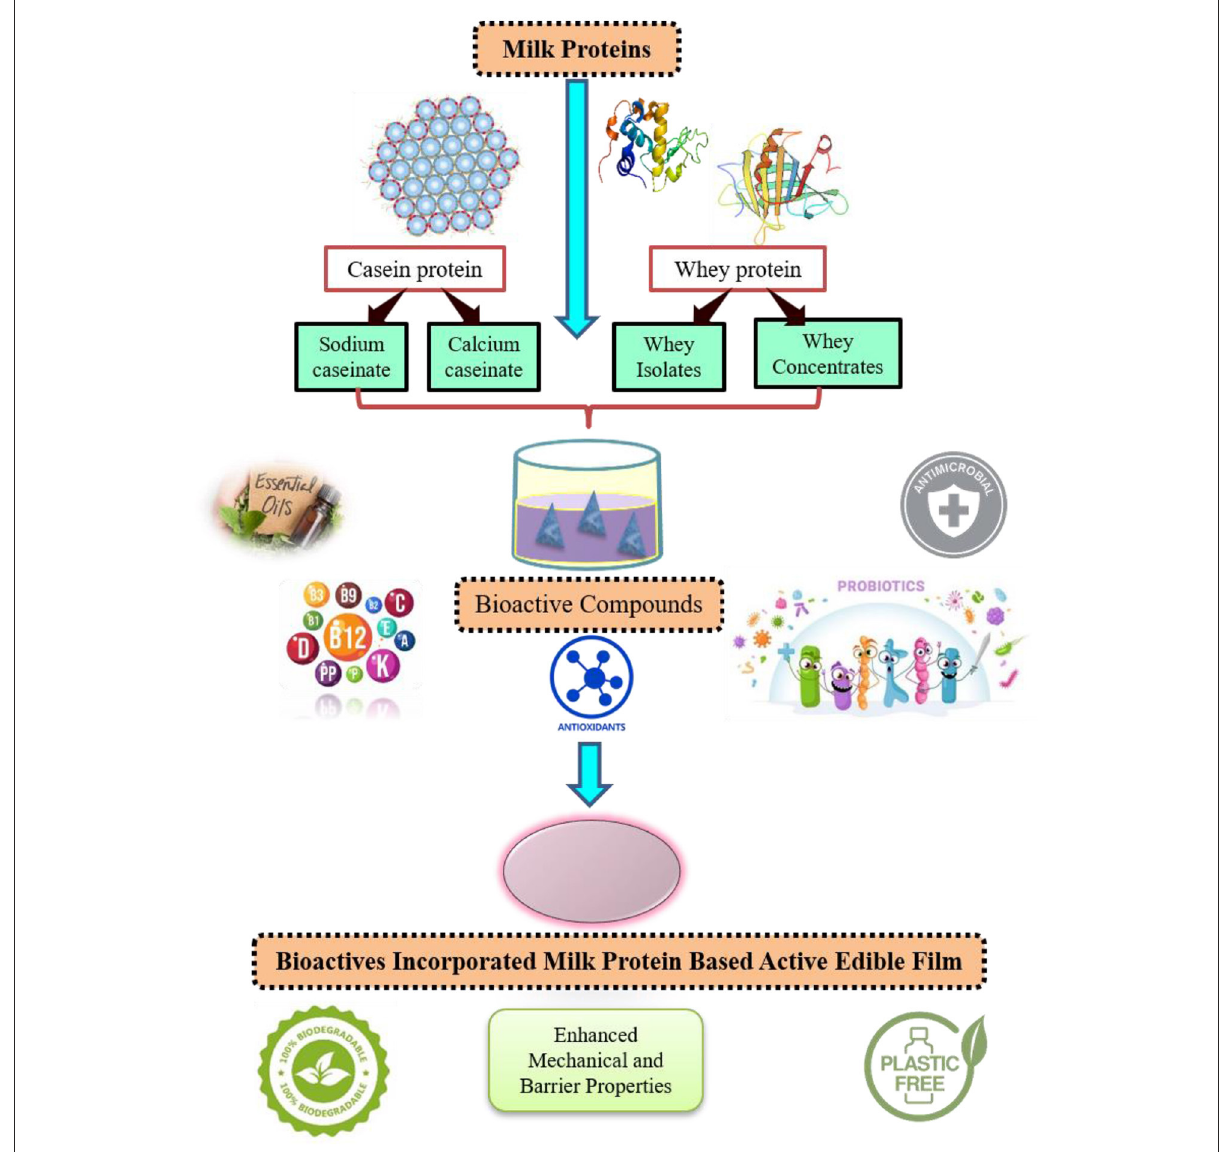
FIGURE1 Techno-functional characteristics of milk protein-based active edible packaging